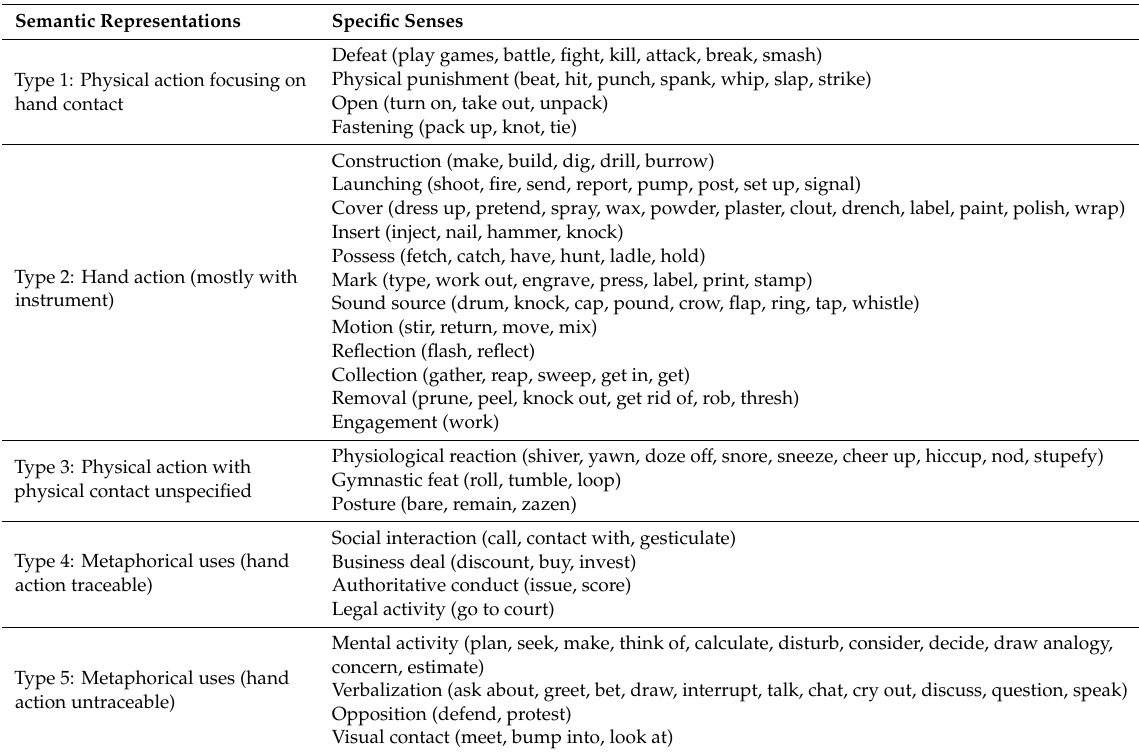
Table 1. Semantic representations and senses of the target verb 打 dˇa (Gao